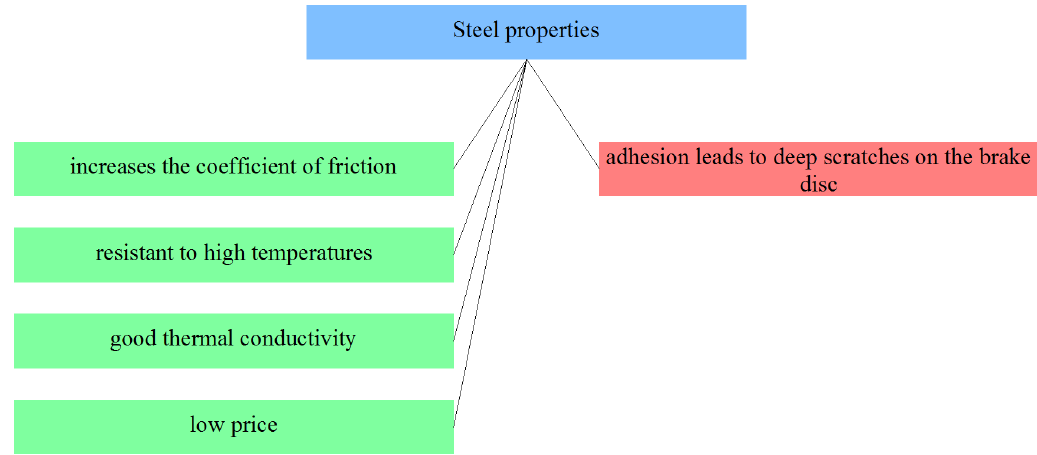
Figure 27: Selected steel composites properties from the point of view of applicability in friction